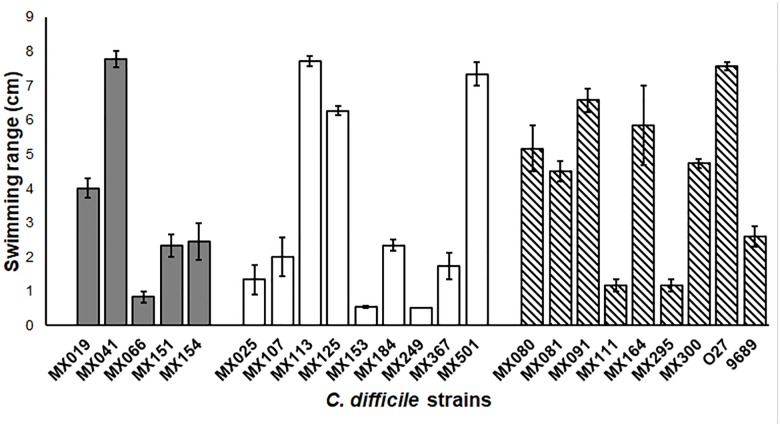
Non-toxigenic C. difficile motility. Range motility of C. difficile non-toxigenic and toxigenic strains. Cells were grown in soft BHI agar (0.15% agar) for 18 h, and swimming range was measure. Gray bars: cdtB+tcdA+tcdB+ strains. White bars: cdtB−tcdA−tcdB− strains. Striped bars: control toxigenic strains. Values represent the average ± standard deviation (SD) from three independent experiments. p > 0.05.